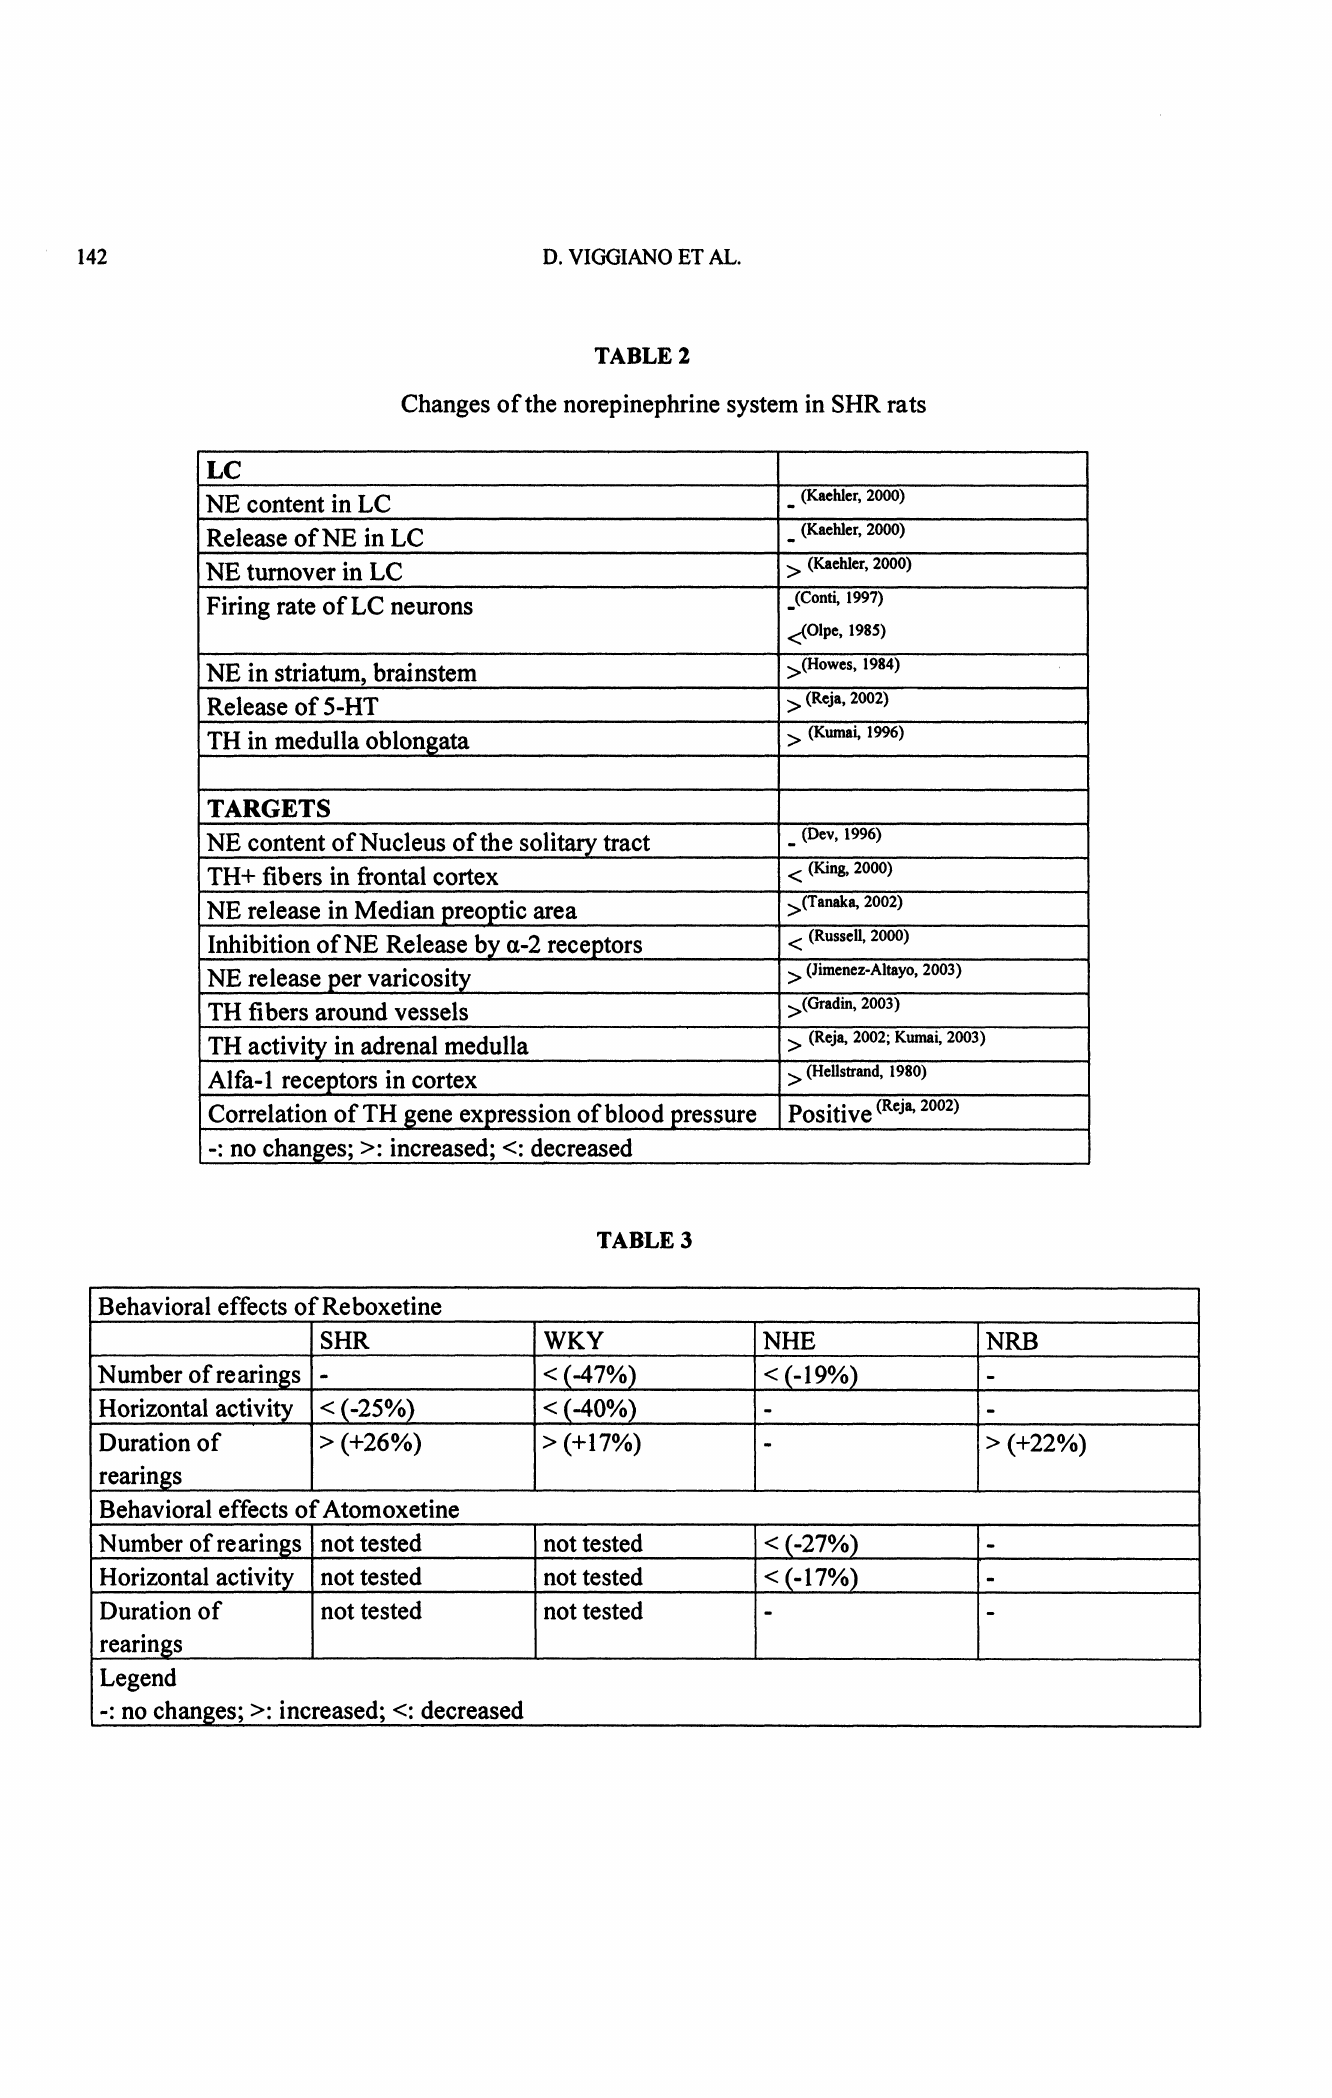
Behavioral effects of